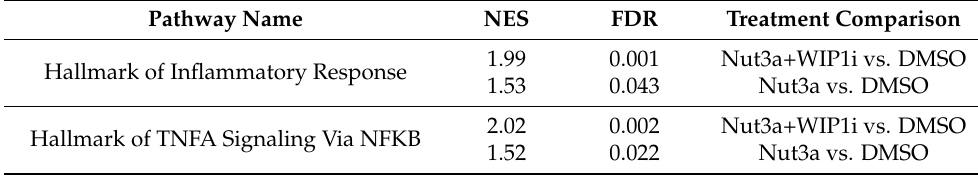
Table 3. Most significant enriched pathways in NOMO-1 cells upon drug treatment.